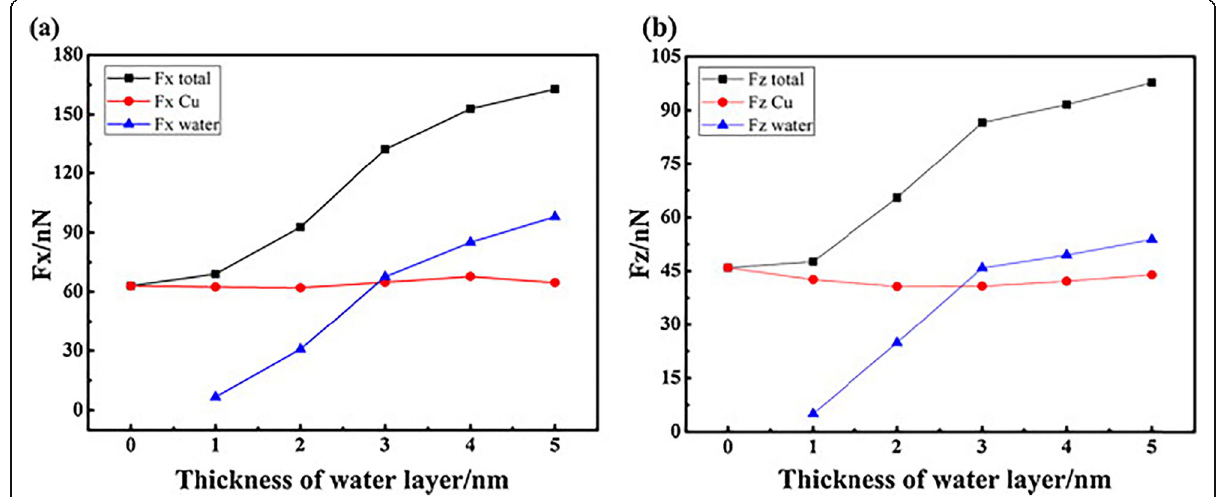
Fig. 3 a Variation of average scratching forces with change in water layer thickness: a tangential forces and b normal forces